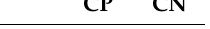
Table 4. Detection rate of dynamic hazardous objects in the front direction (nighttime).